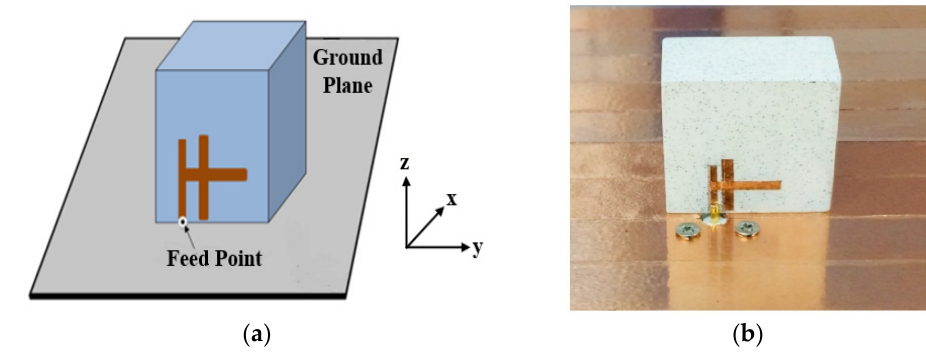
Figure 5. A singly-fed rectangular DRA: ( a ) proposed configuration; ( b ) fabricated [42]. In addition, a coaxial probe can be used to feed a DRA. The connector’s inner con- ductor extends through the dielectric and is soldered to the radiating element, whereas the outer conductor is connected to the ground plane. In [45], two similar truncated corner liquid dielectric resonators (LDRs) are fed by a single coaxial probe for stimulating the